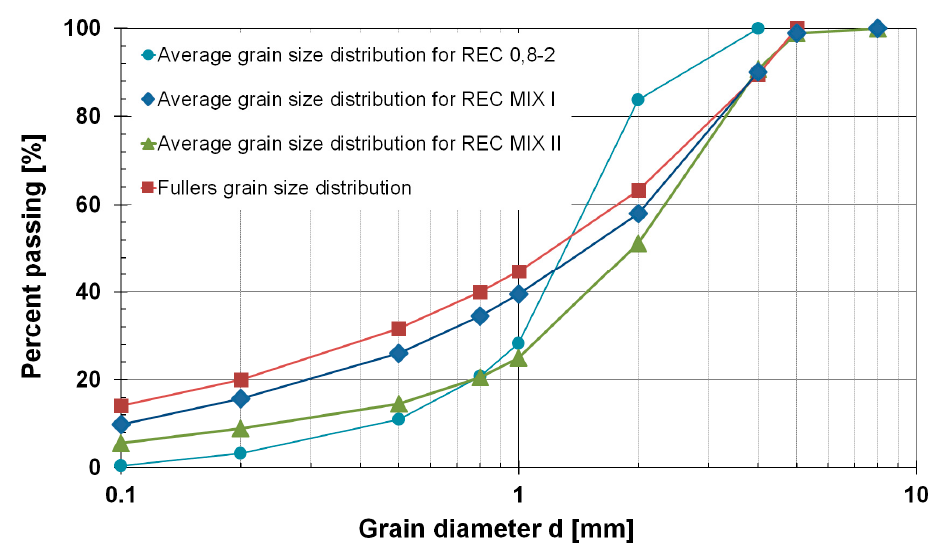
Figure 4. Average grain size distributions for the tested granulated bentonite mixtures and comparison with the ideal grain size distribution given by the Fullers